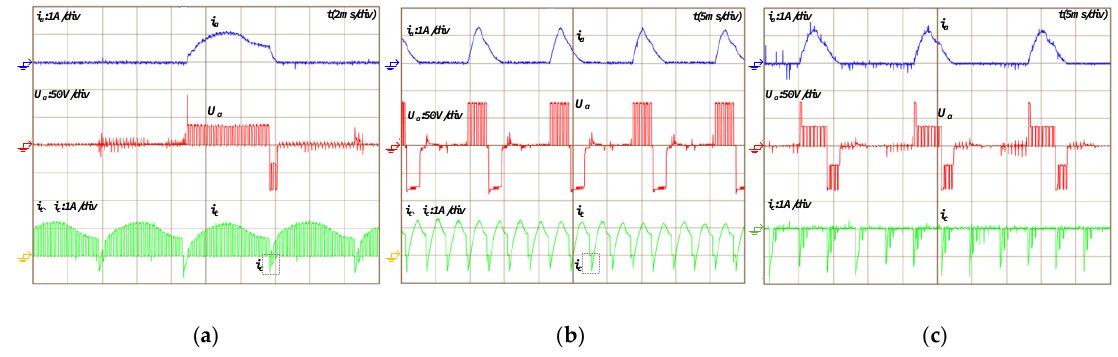
Figure 12. The experimental waveforms of the proposed motor drive operating at 600 rpm. ( a ) Powering by the battery pack. ( b ) Powering by the PV panels and battery pack together. ( c ) Powering by the PV panels.